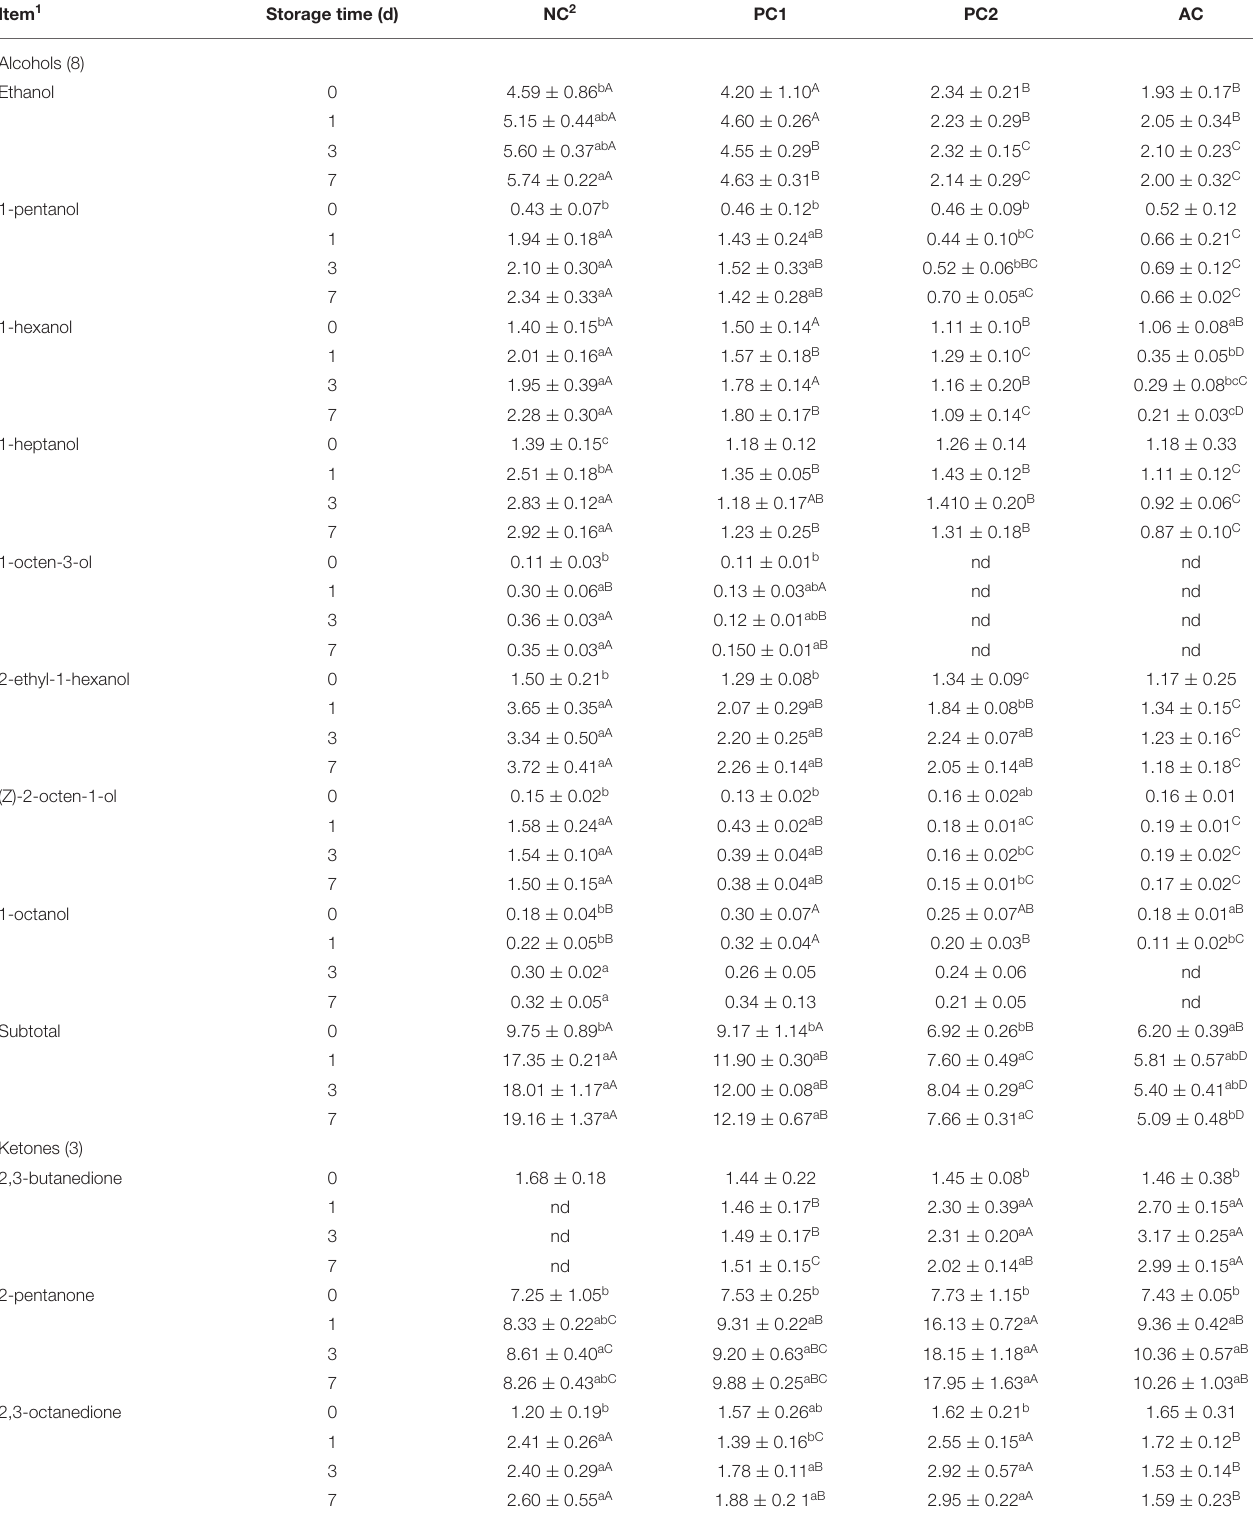
TABLE 4 | Effect of PCP on relative contents of volatile compounds in milk during storage period